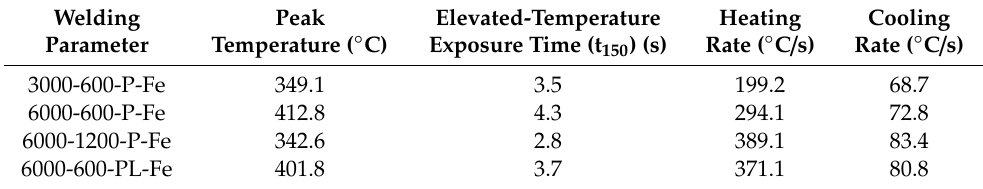
Figure 8. Welding thermal cycles of the joints produced using parameters of ( a ) 3000-600-P-Fe, ( b ) Table 2. Main parameters of welding thermal cycles at weld